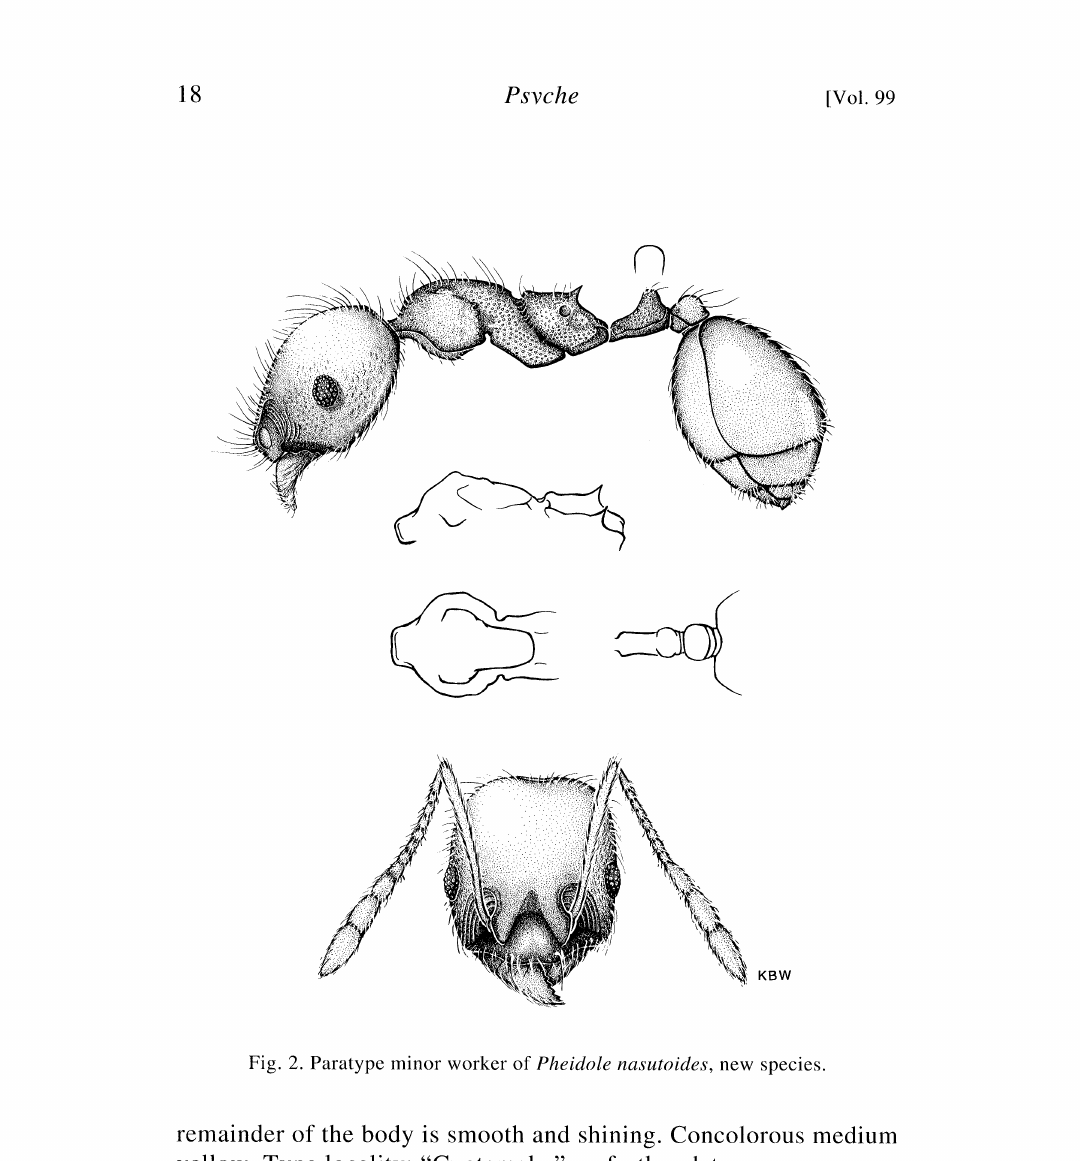
Fig. 2. Paratype minor worker of Pheidole nasutoides, new